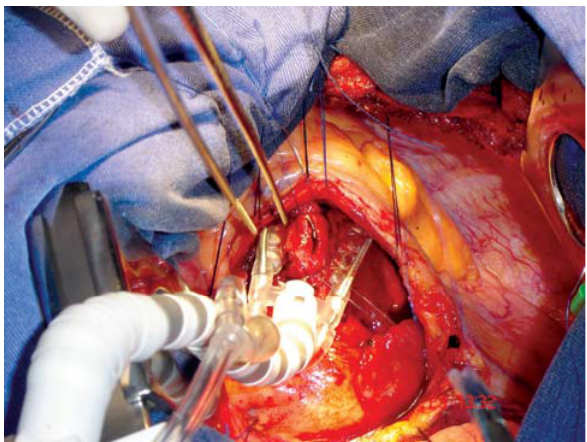
Fig. 3 - Estabilização da artéria para confecção da anastomose com estabilizador Octopus